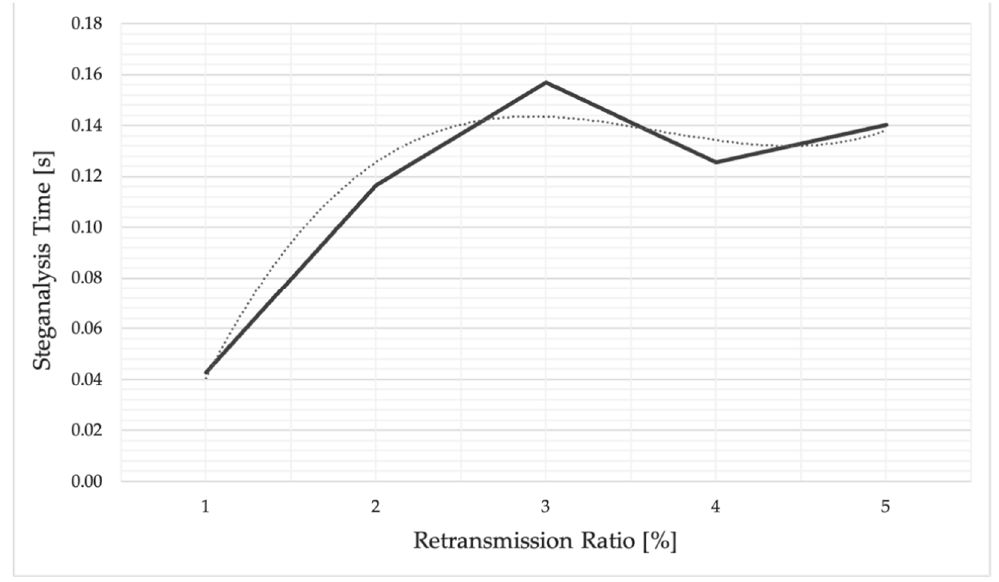
Figure 9. Second-layer steganalysis time .